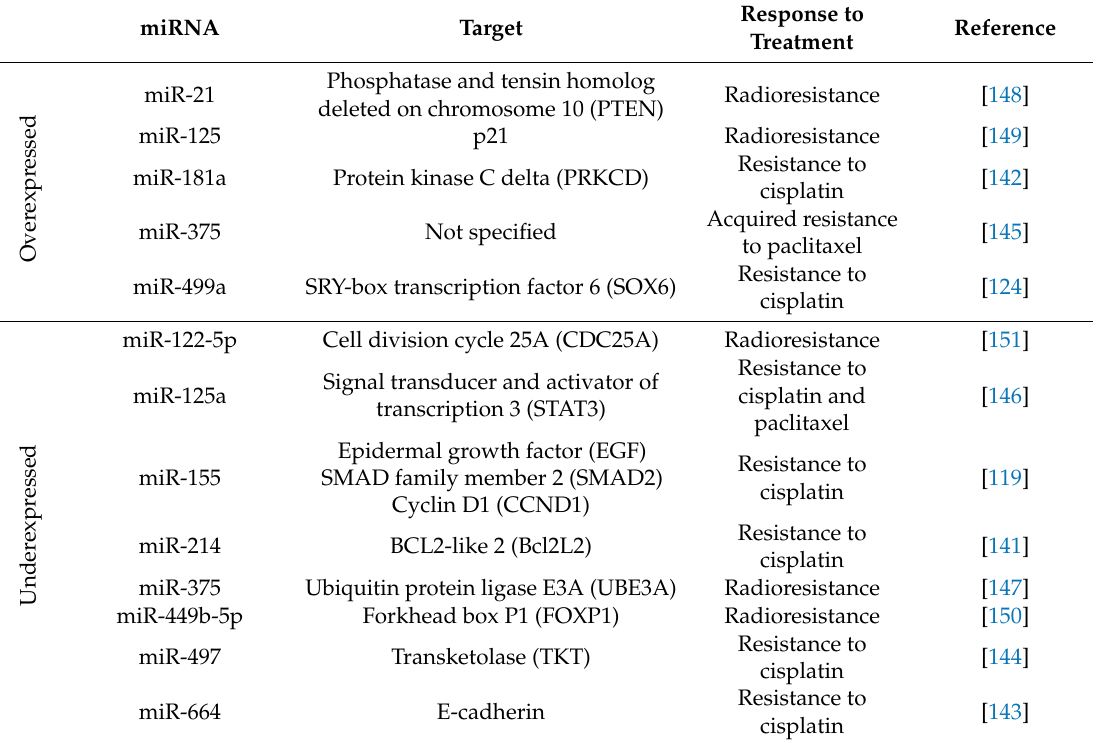
Table 3. Impact of dysregulated miRNA on standard cervical cancer (CC) treatment. miRNA Target